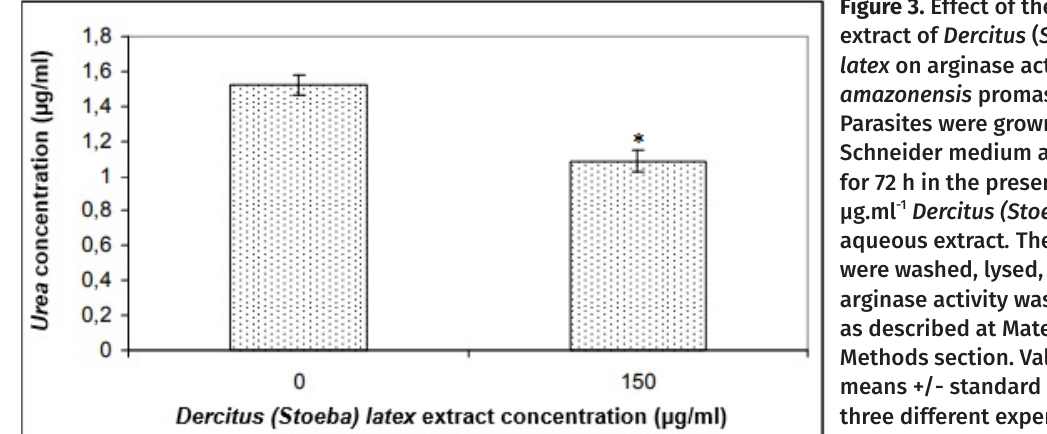
Figure 3. Effect of the aqueous extract of Dercitus ( Stoeba ) latex on arginase activity of